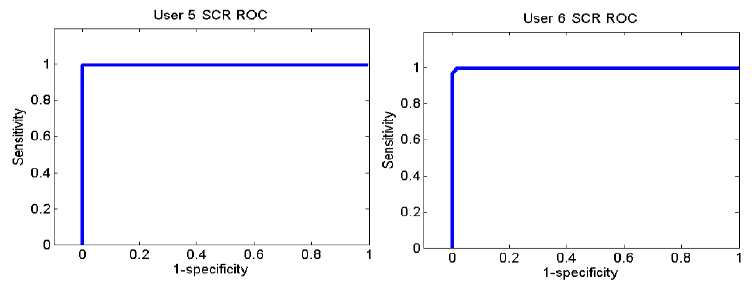
Figure 31. ROC curve of users 5 and 6 from Sounds Test.